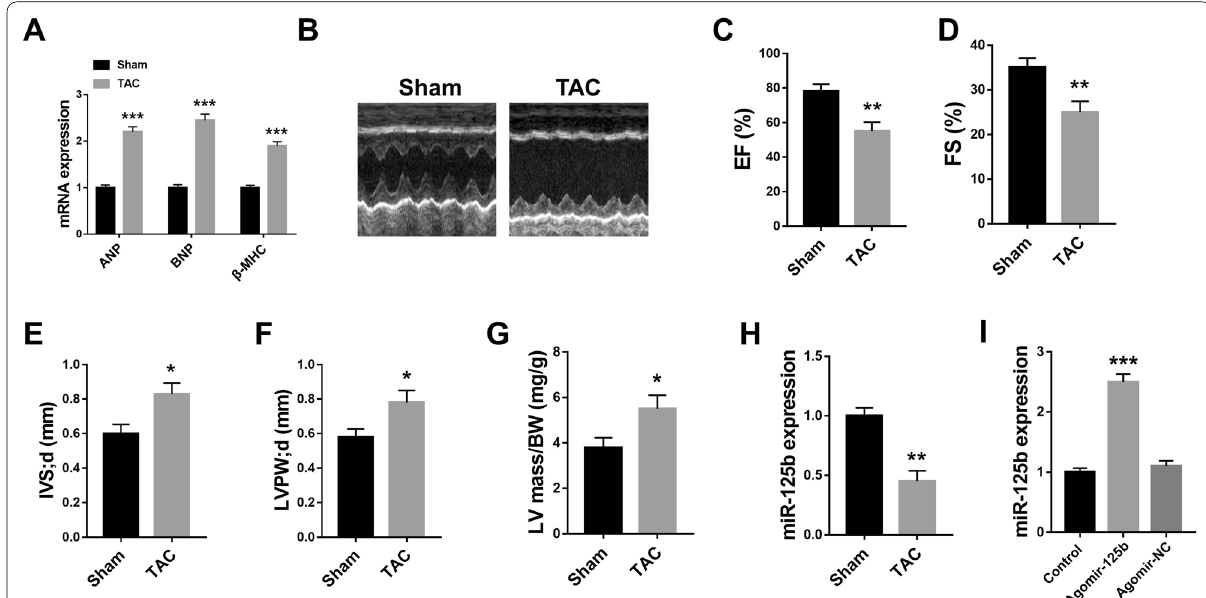
Fig. 1 MiR-125b was downregulated in the heart tissues of HF mice. Mice were treated with or without TAC, and the structure and function of mice hearts were evaluated ten weeks after TAC operation by high resolution small animal ultrasound system and analyzed by M mode. A The mRNA levels of ANP, BNP and β-MHC were evaluated by qRT-PCR (n 5). B Representative images of echocardiographic measurements of mice hearts = (n 8). C Left ventricular ejection fraction (EF%) (n 8). D Left ventricular fractional shortening (FS%) (n 8). E Left ventricular septal thickness; = = = diastole (IVS; d) (n 8). F Left ventricular posterior wall thickness; diastole, (LVPW; d) (n 8). G Left ventricular mass/body weight (LV mass/BW) = = (n 8). H The mRNA level of miR-125b was evaluated by qRT-PCR (n 5). I Agomir-125b or agomir-NC was injected into mice, and the mRNA level = = of miR-125b was evaluated by qRT-PCR (n 5). * p < 0.05, ** p < 0.01, *** p < 0.001 vs. sham group or control =